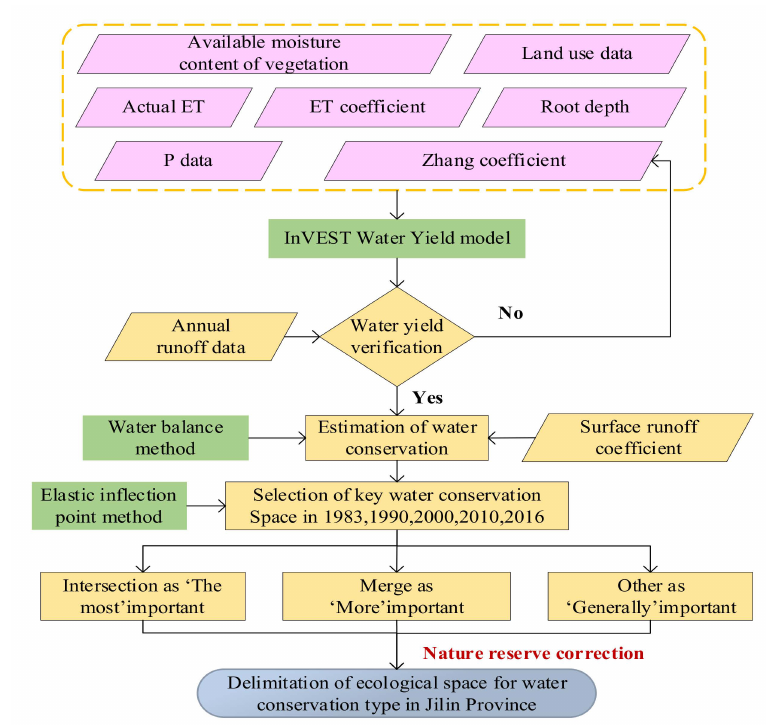
Figure 4. The methodological framework of ecological space